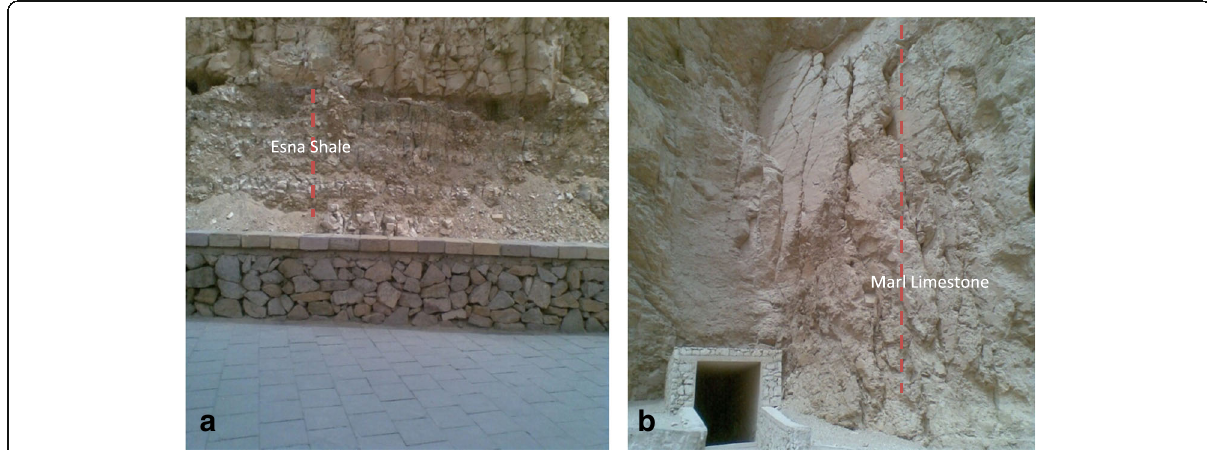
Fig. 4 a Esna Shale and b Marl Limestone (Member 1), Gebel El-Gurnah. The main exposed rocks in Gebel El-Gurnah are the Esna Shale (late Paleocene- Early Eocene) and the conformatably overlying Thebes formation (Early